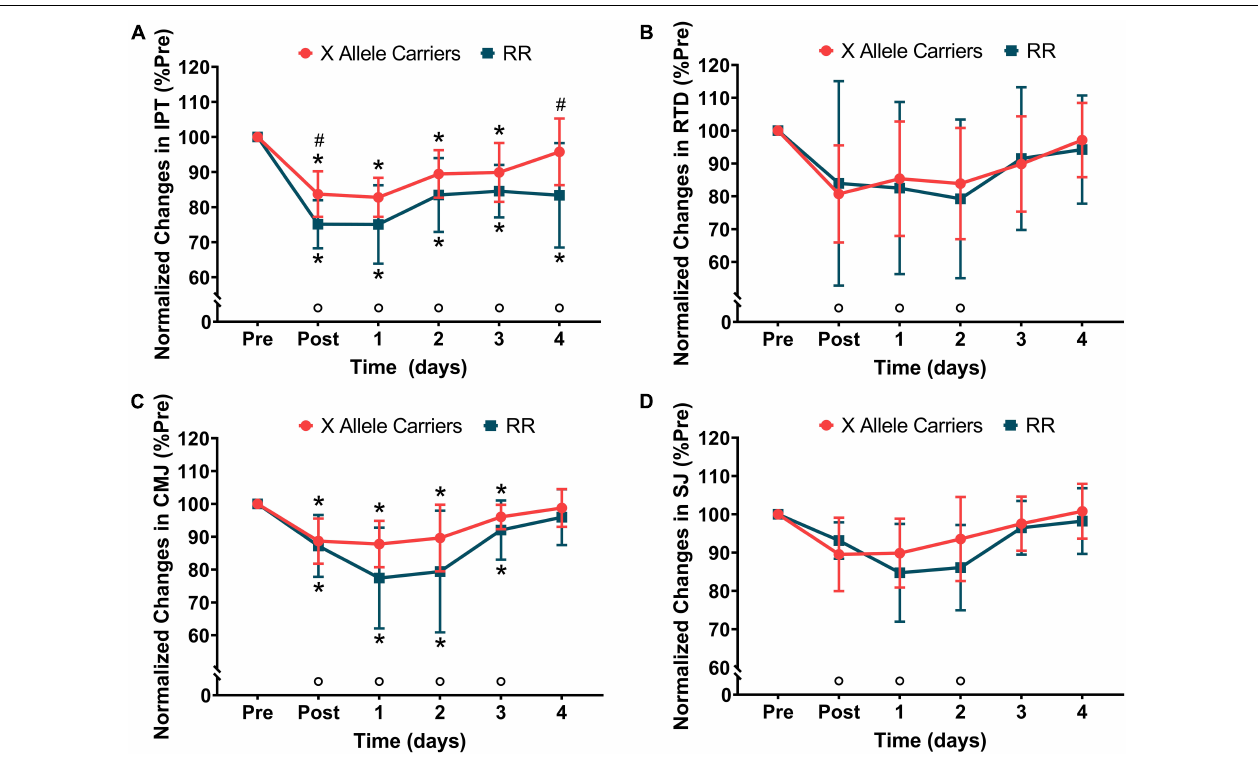
FIGURE 1 | The normalized changes in isometric peak torque (IPT– A ), rate of torque development (RTD– B ), countermovement jump height (CMJ– C ), and squat jump height (SJ– D ) following downhill running for the RR and X allele carrying groups. ◦ P < 0.05 compared with pre for both the groups together; * P < 0.05 compared with pre for the same group; # P < 0.05 compared with RR at the same time point.